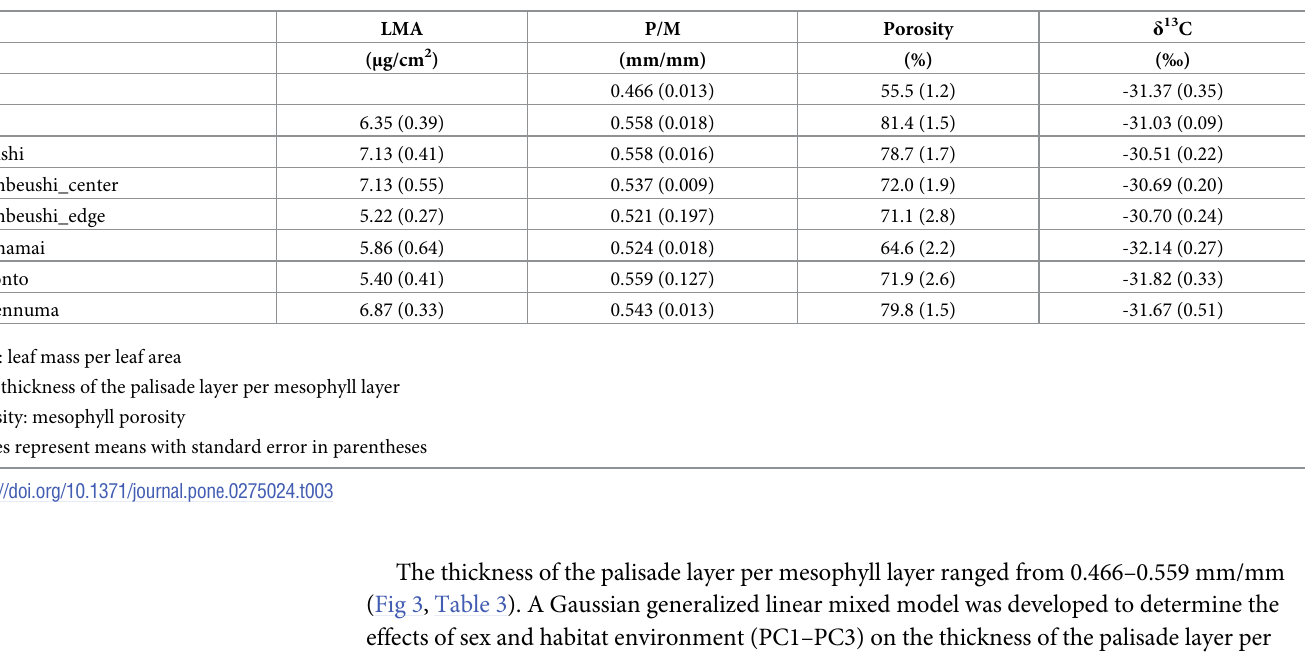
Table 3. Leaf characteristics.